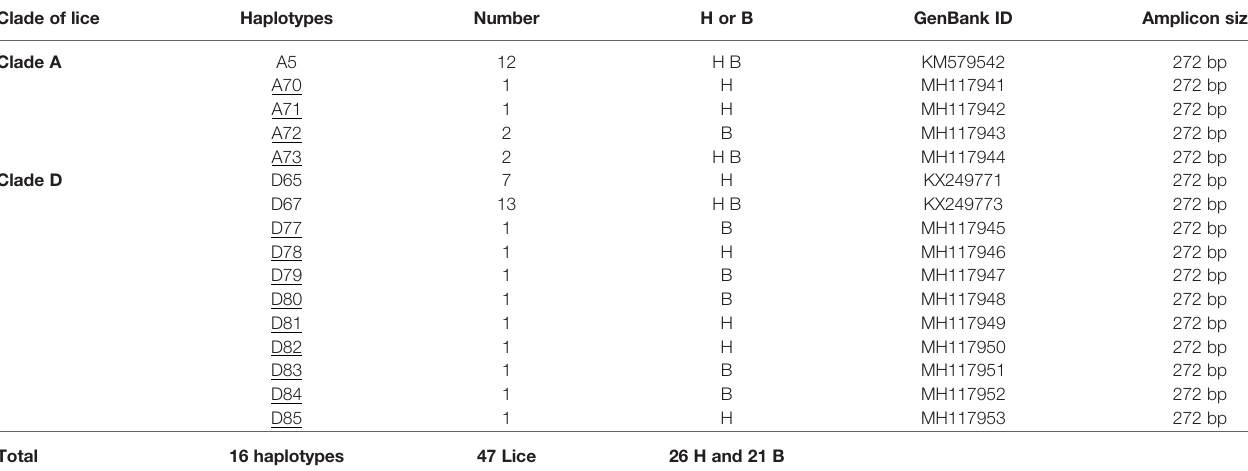
TABLE 2 | Haplotype frequency of head and body lice identi fi ed from infested pygmy individuals in Itury, Congo-RDC. Clade of lice